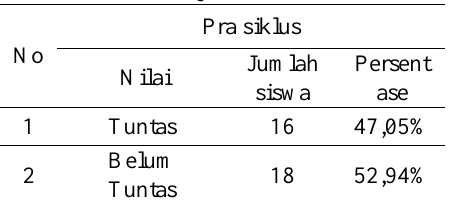
Tabel 1 . Distribusi Frekuensi Pra Siklus Nilai Mata Pelajaran IPA Pra siklus No